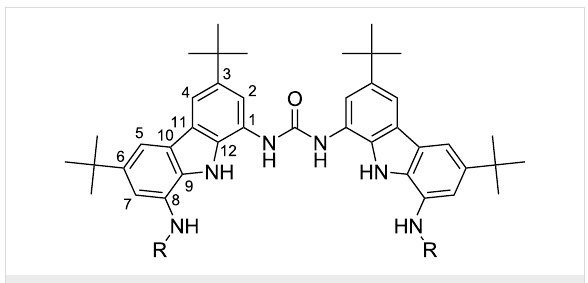
Figure 1: The biscarbazolylurea